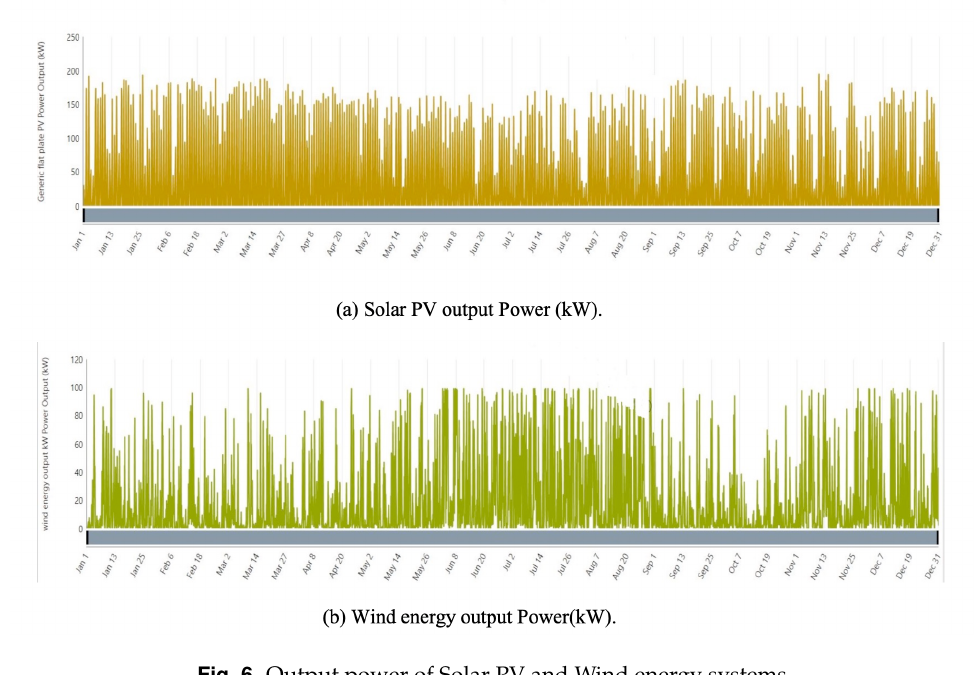
Fig. 6. Output power of Solar PV and Wind energy systems Table 4. Comparison of cost with other Algorithm